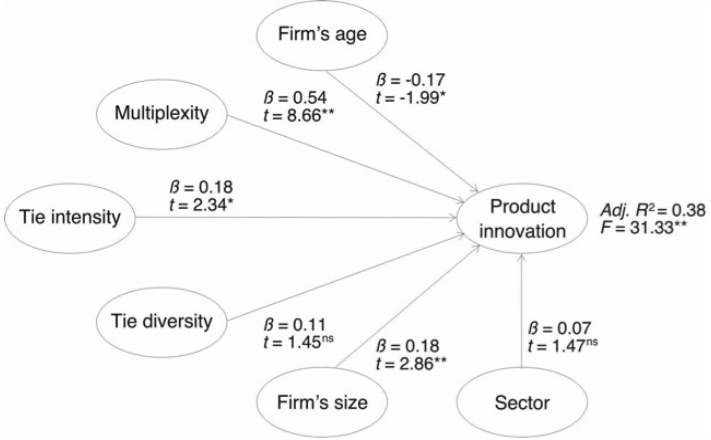
Fig. 4. Results of the analysis of the second